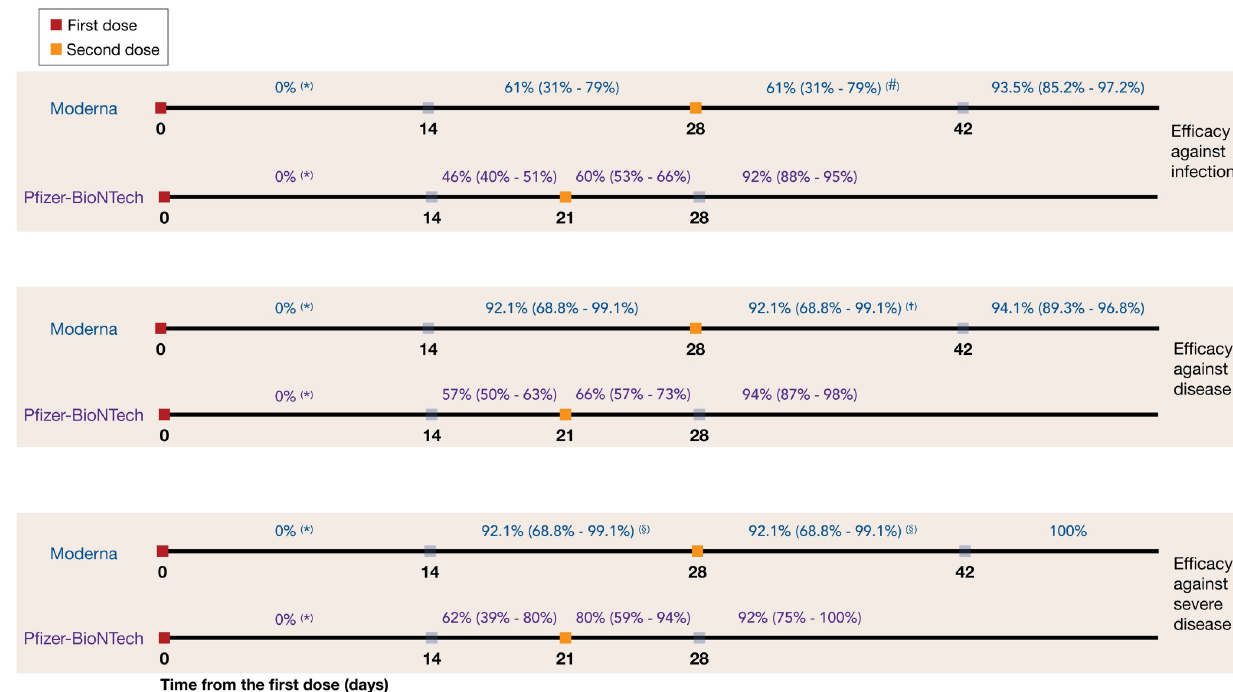
Fig 1. Efficacy of Moderna and Pfizer-BioNTech vaccines against all infection, symptomatic disease, and severe disease, derived from published studies and US FDA briefing documents [3,4,6,22–24]. ( � ) During the first 14 days following the first dose of vaccines, there was no statistically significant difference between the protection in the vaccinated and unvaccinated cohorts. (#) Conservatively assumed to be the same as efficacy against infection during the preceding 14 days (prior to the second dose). (†) Conservatively assumed to be the same as efficacy against severe disease during the preceding 14 days (prior to the second dose). (§) Assumed to be the same as efficacy against symptomatic COVID-19. COVID-19, Coronavirus Disease 2019; FDA, Food and Drug Administration.